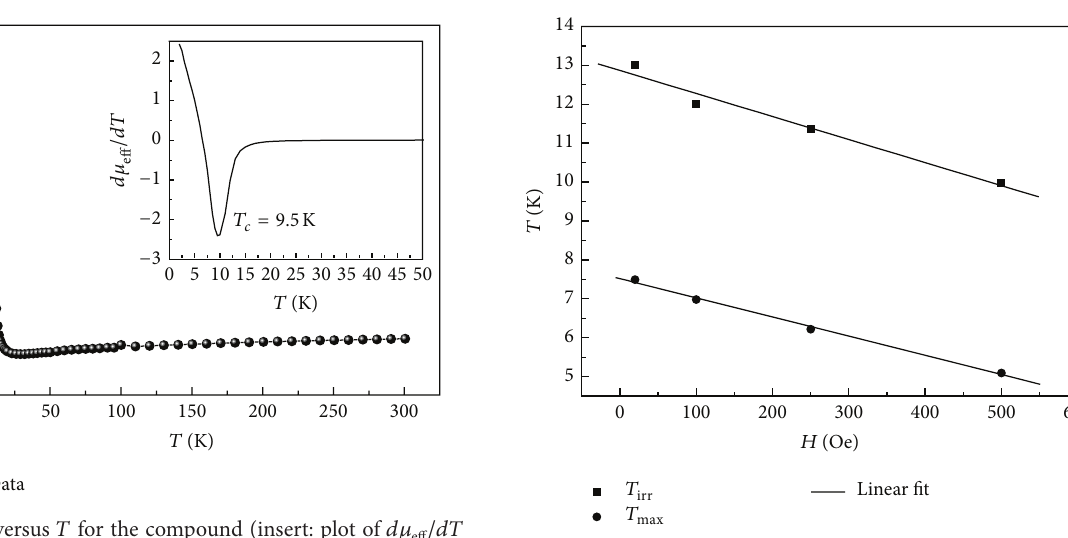
Figure 10: 𝑇 and 𝑇 max versus 𝐻 for the compound. irr